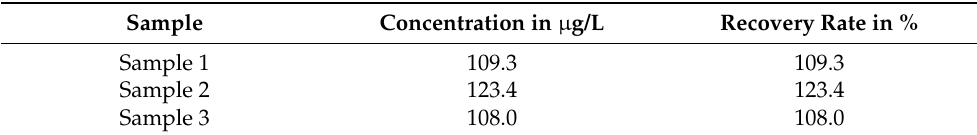
Figure 4. ( a ) Recorded voltammograms of different platinum standard solutions as measured on a bis- muth film on solid state glassy carbon electrode. ( b ) Resulting calibration curve with linear regression (red line). ( c ) Results of the point-to-point gradient linearity test of the linear calibration curve. Table 3. Determined platinum concentrations and recovery rates for three independent tap water samples each spiked with 100.0 µ g/L platinum as measured with a bismuth film on solid state glassy carbon electrode.